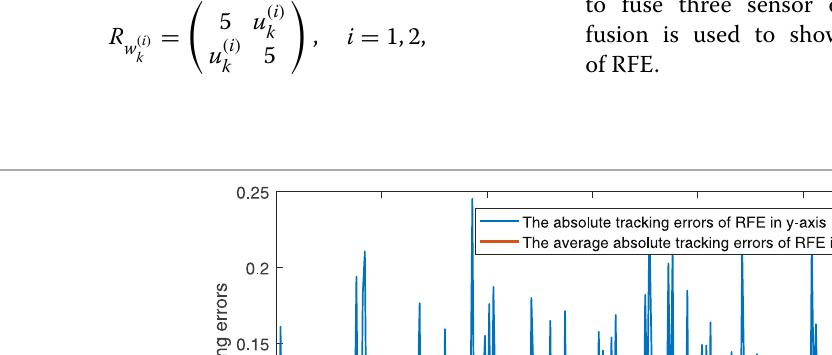
15, 16, and 17, when a i varied from 8 to 14, both the tracking performance of RFE and CI method are degraded. However, the average absolute tracking errors of RFE are always slightly better than that of CI method.